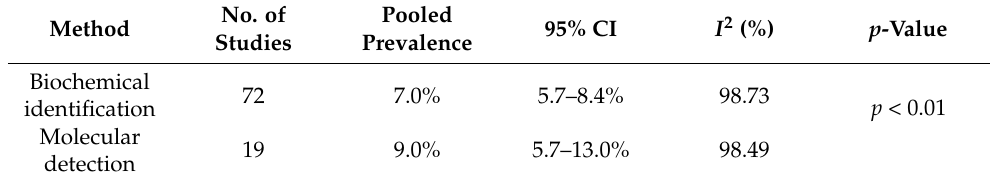
Table 6. Subgroup analysis of the prevalence of L. monocytogenes by different detection methods.